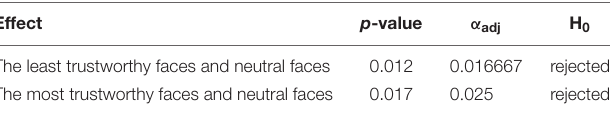
TABLE 4 | The results from the sequential Bonferroni correction of three different t -tests of Experiment 1.